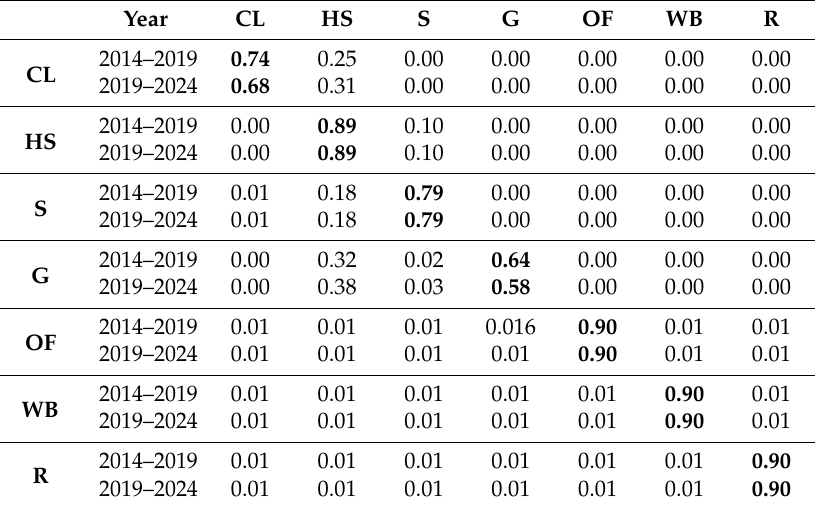
Table 8. Transition probability matrix for 2019 and